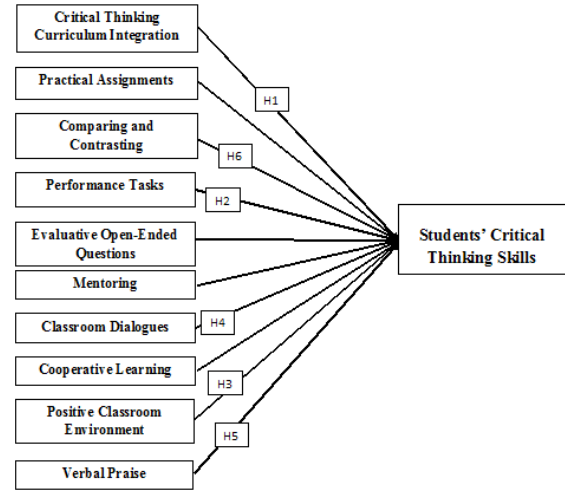
Figure 2. Framework of the